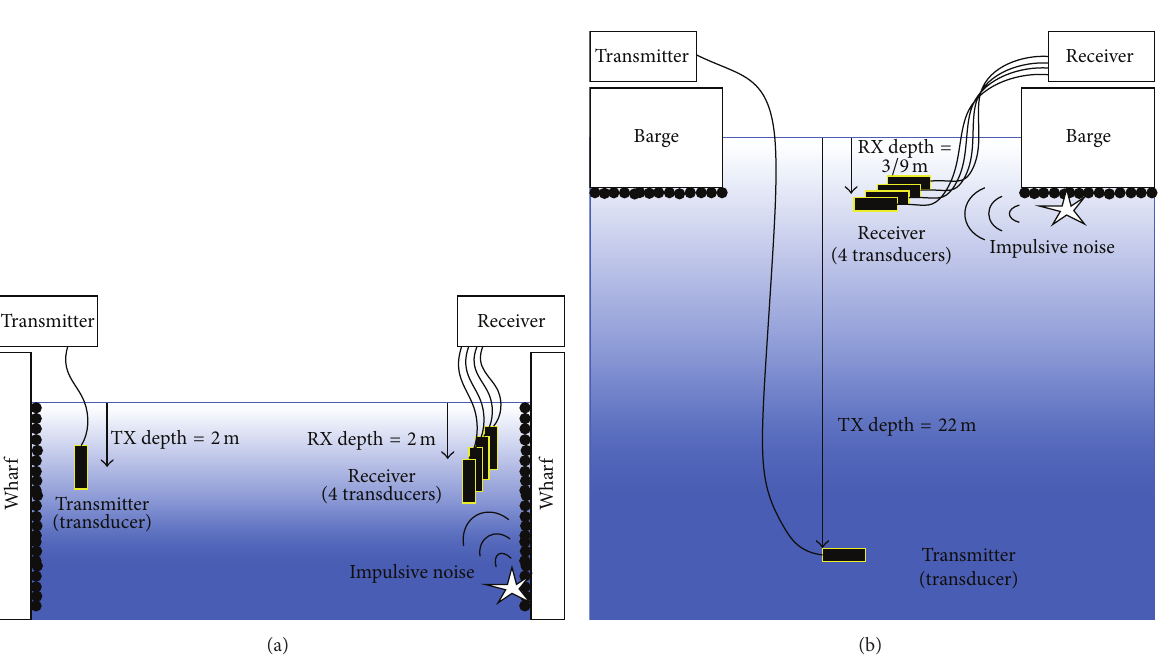
Figure 2: (a) Okinawa experiment at OJIMA fishing port. (b) Shizuoka experiment in UCHIURA